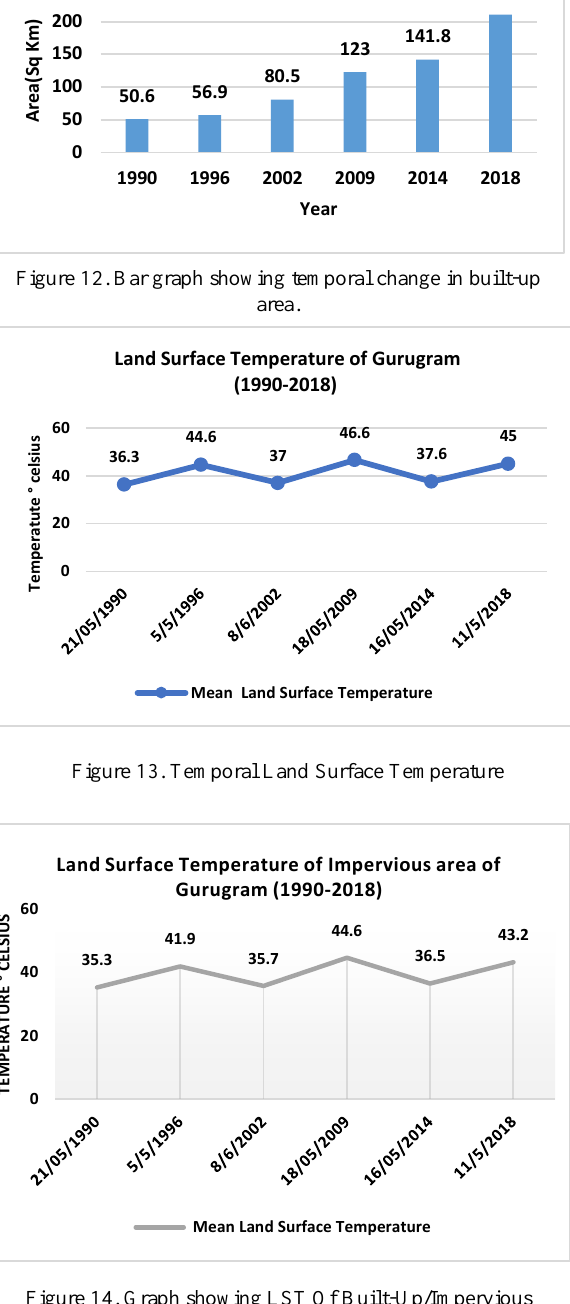
Figure 14. Graph showing LST Of Built-Up/Impervious